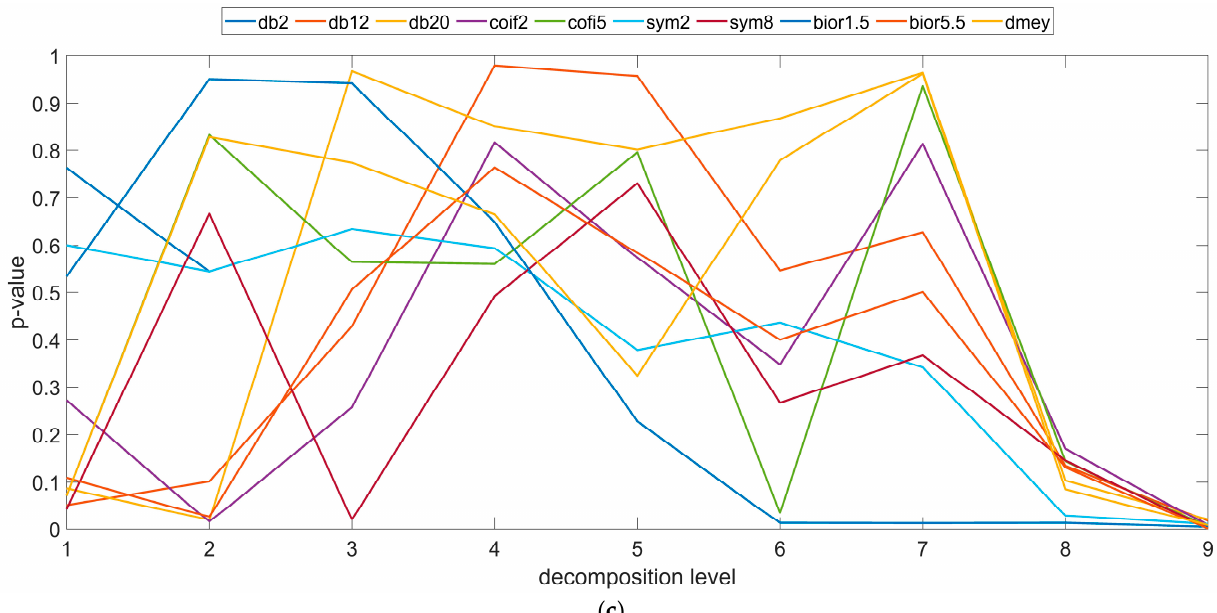
Figure 5. p -value coe ffi cient as a function of angle increment to the building platform, ( a ) 0°, ( b ) 45° and ( c ) 90°.